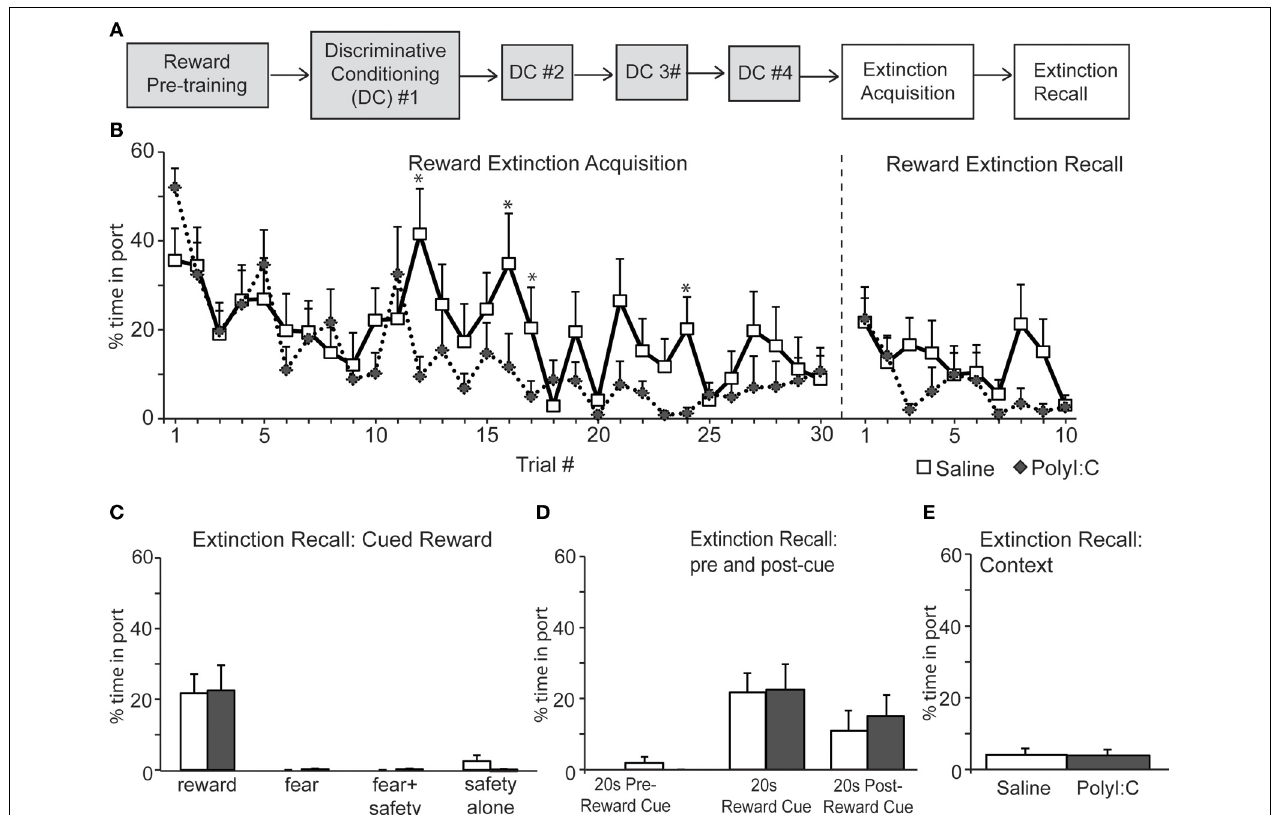
FIGURE 6 | (A) Schematic of experimental design. Rats were pre-trained on the reward cue-reward pellet association followed by 4 Discriminative Conditioning sessions in which the reward cue ( + reward pellet), fear cue ( + footshock), fear + safety cues (no footshock) and safety cue (no footshock) were presented. During Extinction Acquisition all rats received unreinforced presentations of the fear and reward cues. Extinction Recall occurred the next day and consisted of unreinforced presentations of all cues. Data are presented below for the sessions indicated by white boxes. (B, left) Both groups demonstrated significant within session extinction of reward-seeking behavior to the reward cue. Percent time in port to each reward cue presentation is shown. Reward seeking to the last cue presentation was